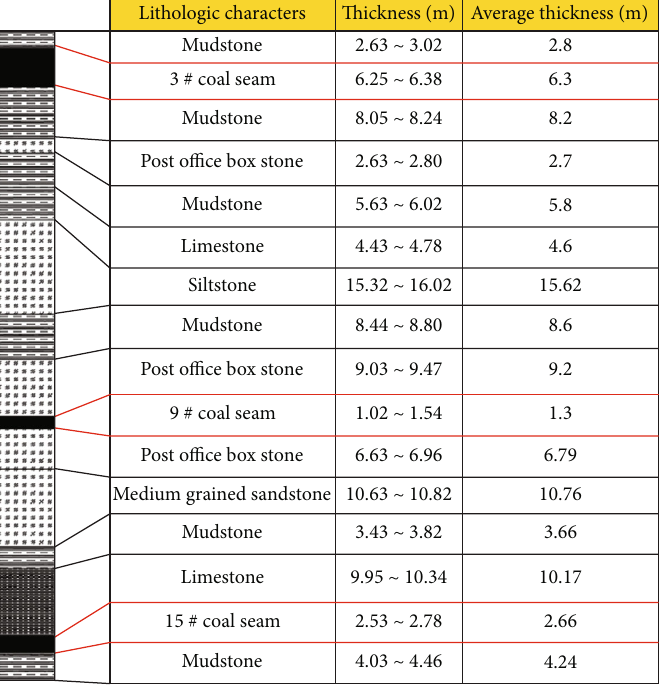
Figure 1: Comprehensive histogram of mine.